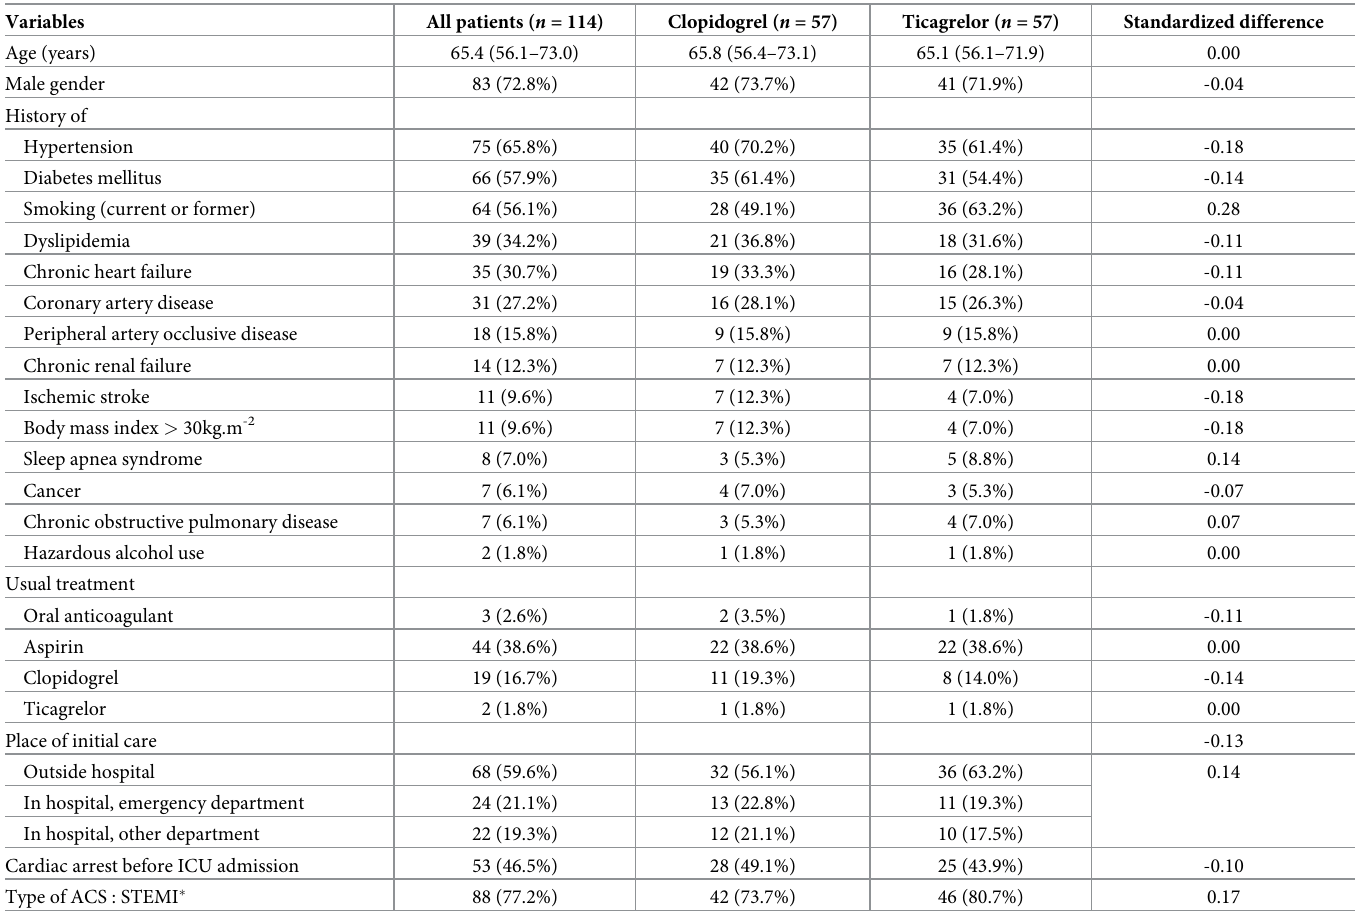
Table 1. Characteristics of the 114 matched patients at study